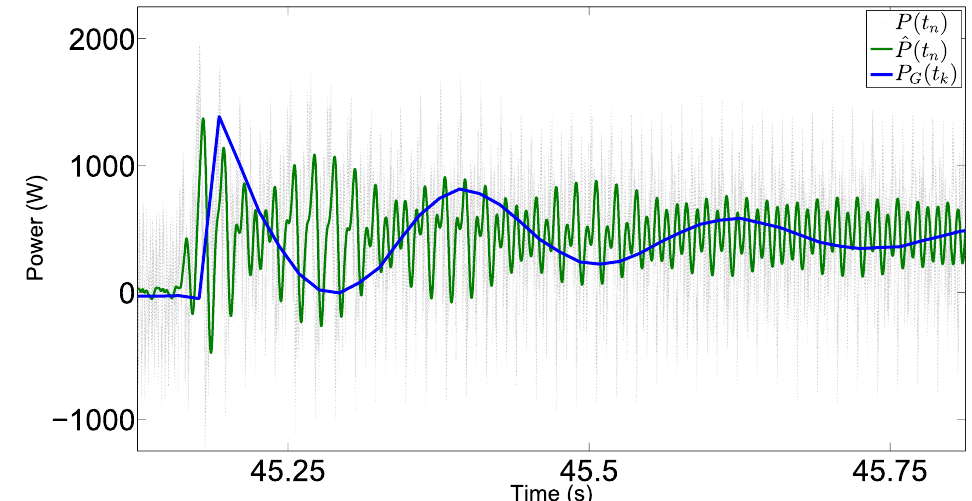
Figure 12. GOLD method actual performance for an unbalanced load, illustrating real power disturbance